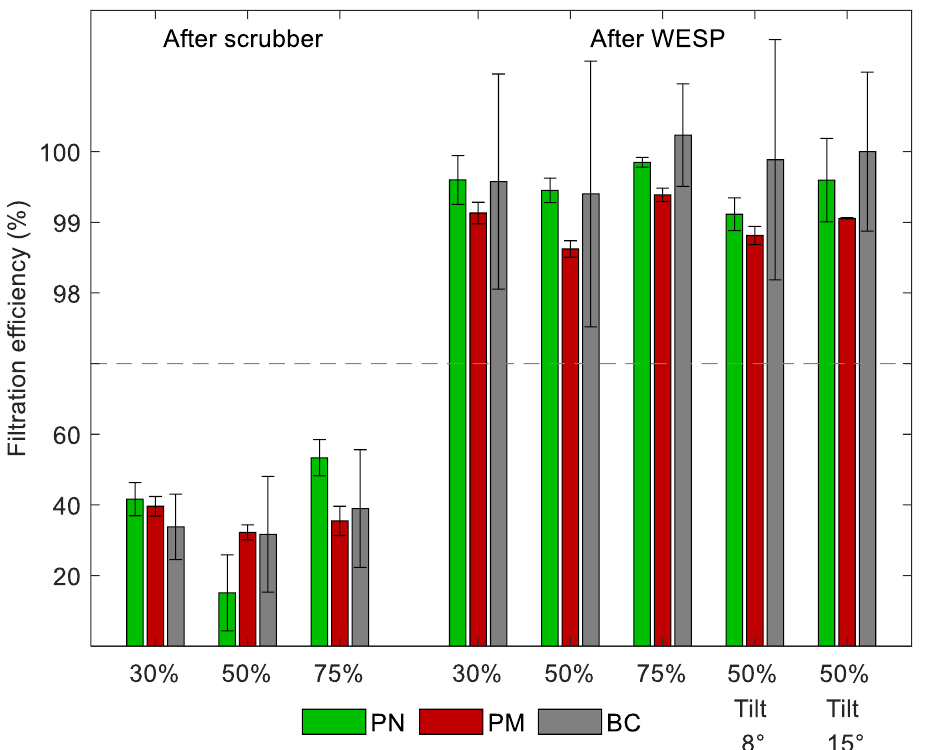
Figure 5. Filtration efficiencies of the scrubber and the entire system measured after the WESP for non-volatile >23 nm particle number (PN), particle mass (PM) and black carbon mass (BC). In the x-axis, the engine load (%) and tilt angle (°) are shown. The fuel was HFO for filtration efficiencies shown in the figure. The error bars represent statistical standard uncertainties calculated from standard deviations of measured concentrations. Note the different y-scale for after scrubber and after WESP points.